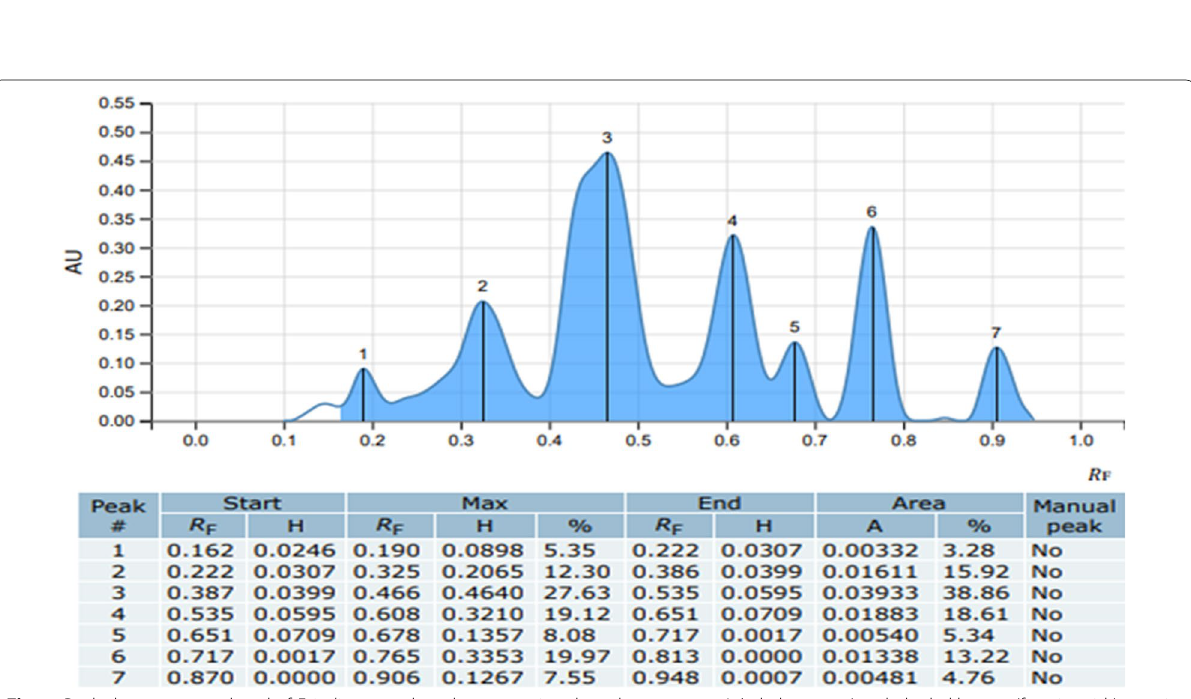
Fig. 4 Peak chromatogram band of E. indicum methanol extract using the solvent system A (ethyl acetate/methyl ethyl ketone/formic acid/water in the ratio of